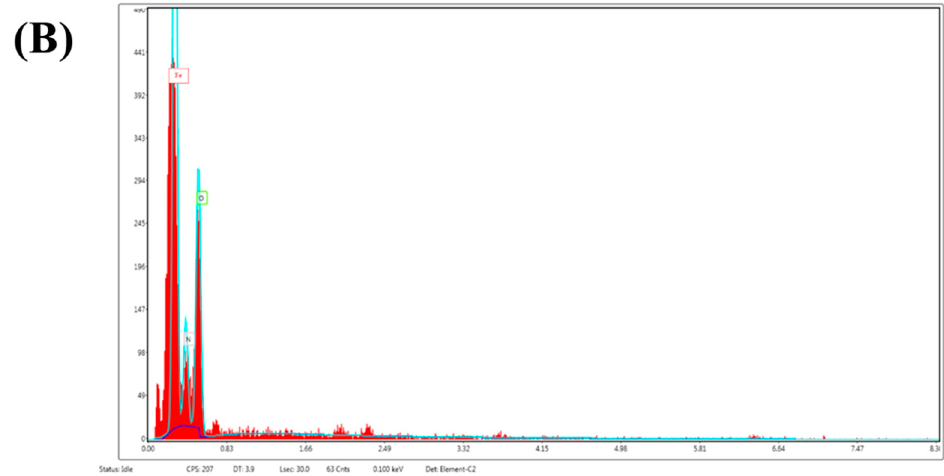
Figure 6. ( A ) Showing EDX spot of which elemental composition is determined. ( B ) Graphical representation of detected elements.